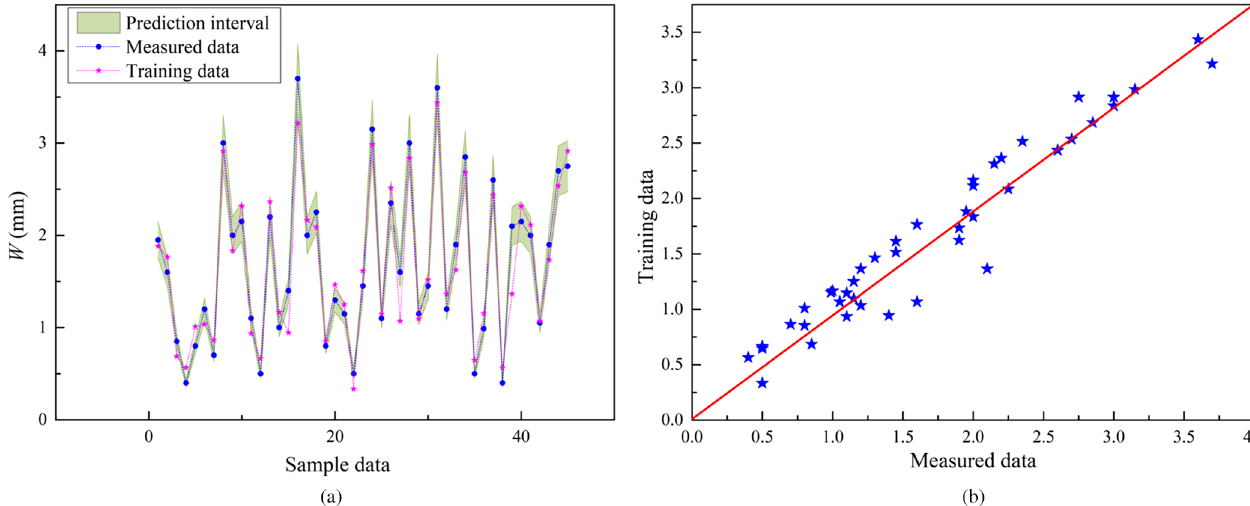
Fig. 5. The SVR training results of cylinder liner wear. (a) Comparison of training and measured data on the training set. (b) Performance of SVR on the training set.